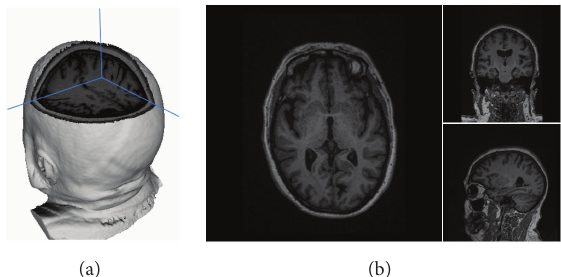
Figure 1: (a) Three-dimensional configuration of brain MRI images from the database used to obtain prior information for the proposed initial guesses. The head surface is rendered using the medical visualization software Mango. (b) Axial (left), coronal (upper right), and sagittal (lower right) views of the brain.